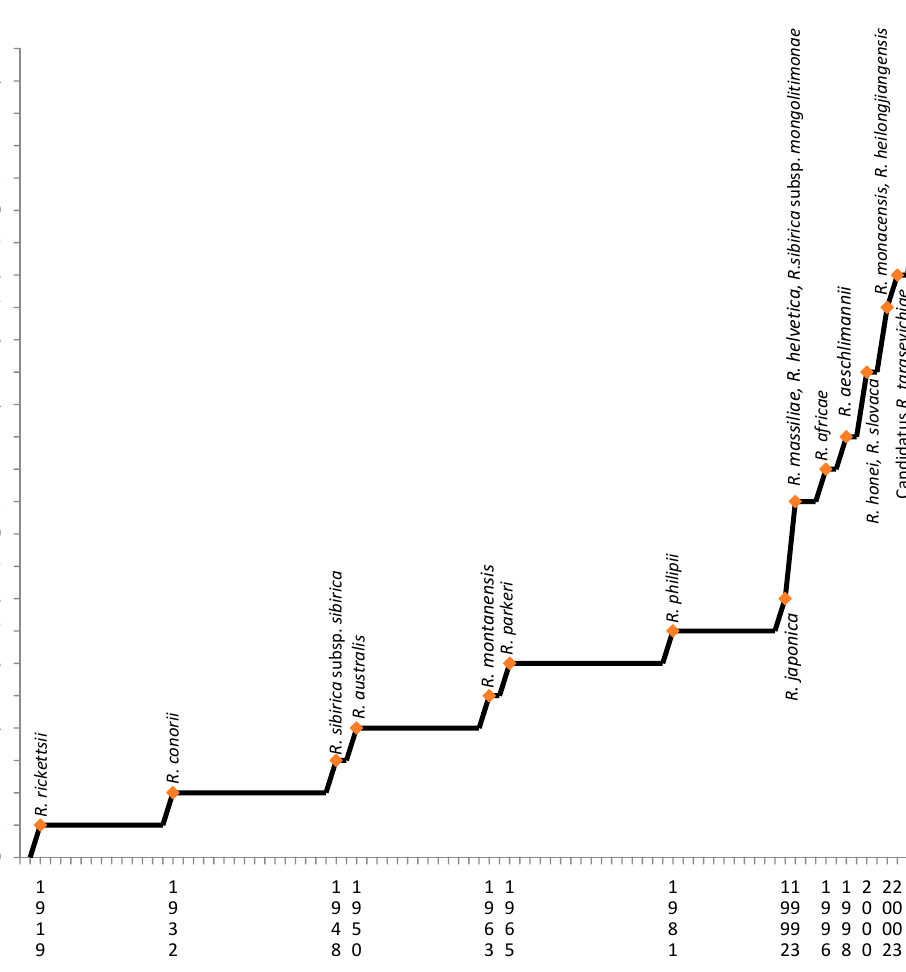
Figure 1. The number of pathogenic species of bacteria belonging to the genus Rickettsia known in particular years. The first publication with description of the species was considered as the date.